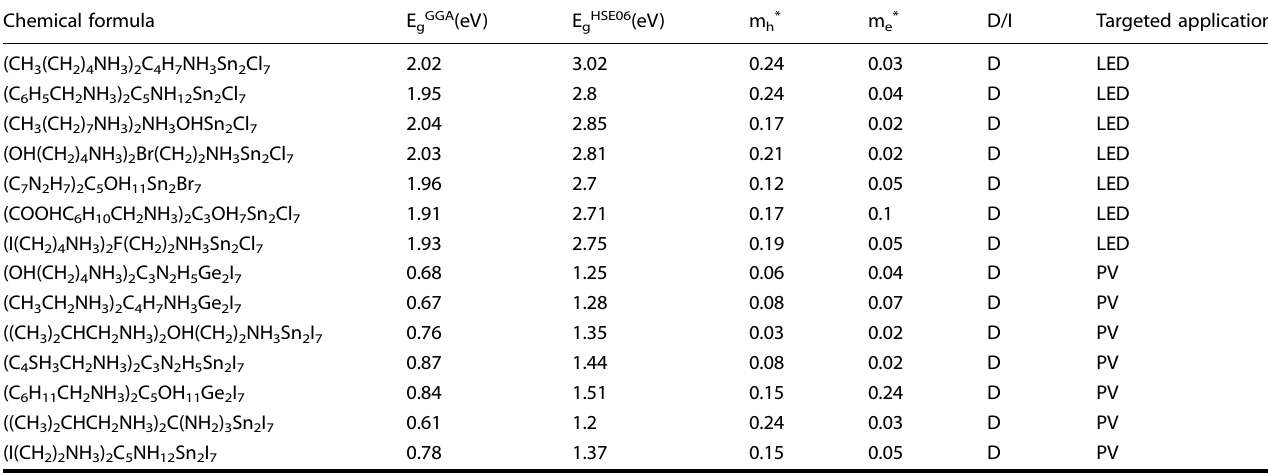
Table 1. Details for the 14 hypothetical HOIPs. Chemical